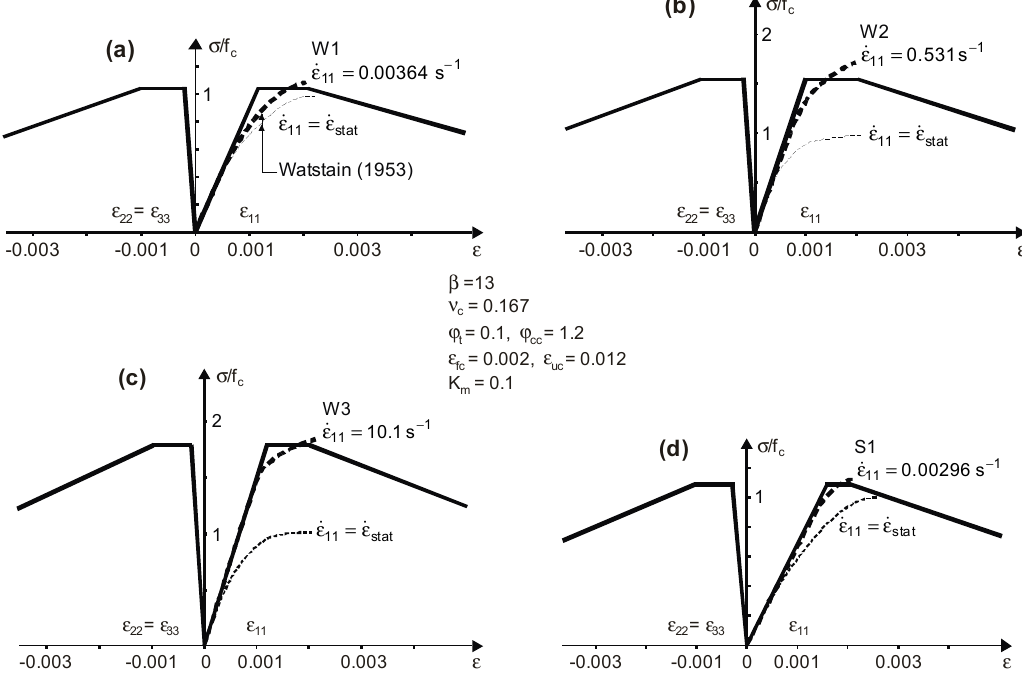
Figure 12. Comparison of the proposed model with Watstein’s [10] dynamic experimental results for di ff erent test samples and strain rate: ( a ) W1 different test samples and strain rate: ( a ) W1 𝜀(cid:4662) = 0.00364 𝑠 (cid:2879)(cid:2869) ; ( b ) W2 𝜀(cid:4662) = 0.531 𝑠 (cid:2879)(cid:2869) ; ( c ) W3 𝜀(cid:4662) = . ε = ( d ) S1 0.00296 s − 1 10.1 𝑠 (cid:2879)(cid:2869) ; ( d ) S1 𝜀(cid:4662) = 0.00296 𝑠 (cid:2879)(cid:2869) .